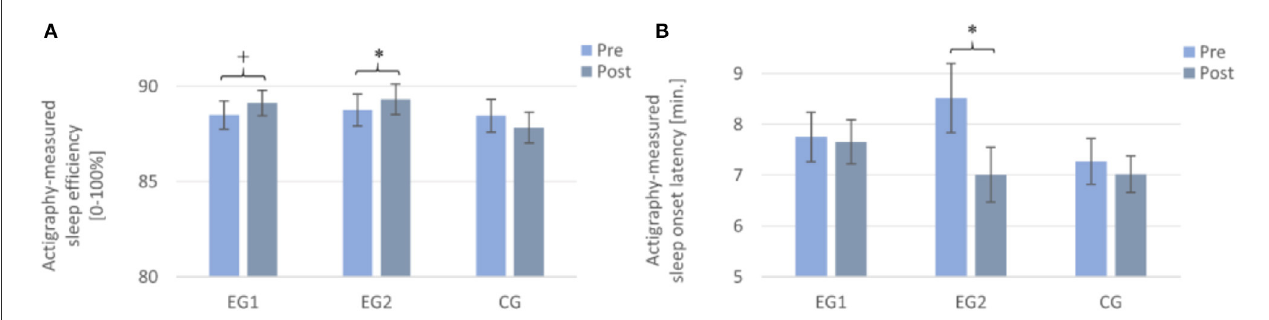
FIGURE3 Actigraphy-recorded parameters from pre to post in all three groups. Note that the EG1 showed a trend toward an improvement from pre to post in (A) sleep efficiency, but not in (B) sleep onset latency; the EG2 improved significantly from pre to post in both measures, while the CG showed no improvement. Measurements were assessed daily and averaged over a week each. EG1 ( n = 34), EG2 ( n = 34), and CG ( n = 32). Asterisks represent significant results, * p < 0.05, + p < 0.10, two-tailed. Error bars display ± 1 standard error. EG1, experimental group one; EG2, experimental group two; CG, control